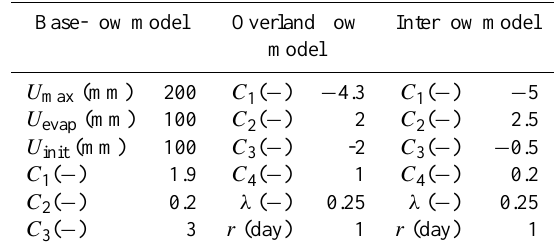
Table 2b. Calibrated parameters of VHM model for Lake Tana